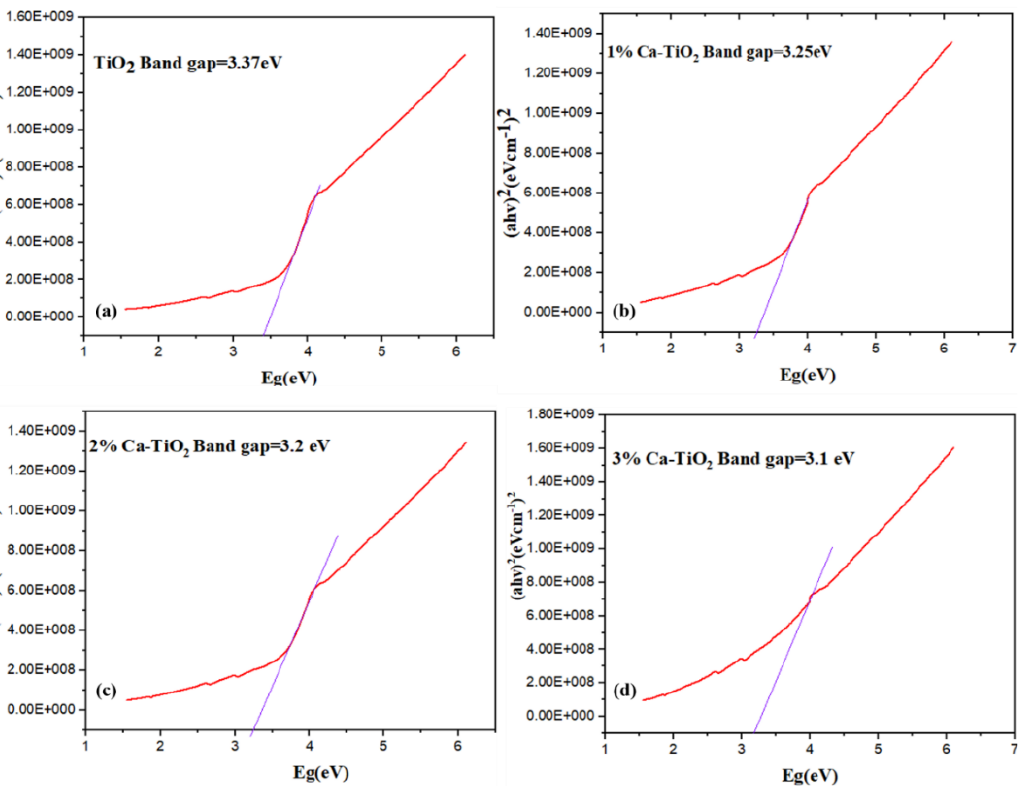
Figure 7. Tauc plots for bandgap analysis of ( a ) pristine TiO 2 , ( b ) 1 wt% Ca-TiO 2 , ( c ) 2 wt% Ca-TiO 2 , and ( d ) 3wt % Ca-TiO 2.